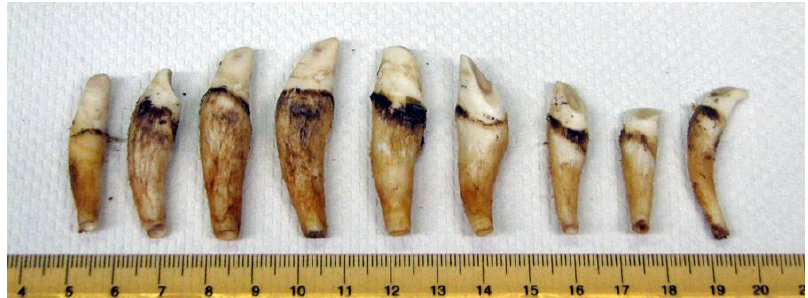
Fig. 2. Variation in size and shape of beluga teeth from one jaw. HI-09-01, MNR-1 through MNR-9 (left to right). Different occlusal wear patterns in the distal surface are apparent also. The extracted teeth show remnants of the periodontal ligament, especially dark at the gingival line, indicating the portion of the tooth contained within the alveolar